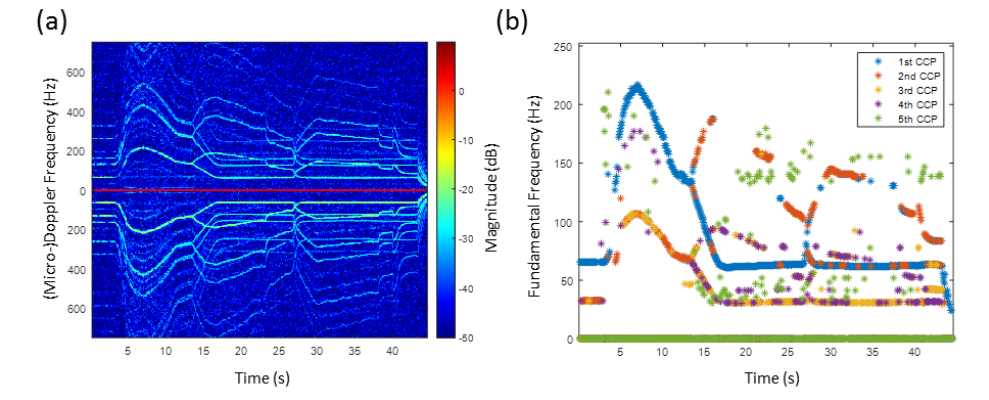
Figure 7. ( a ) HERM lines spectrogram for quadcopter measured by C-band radar; ( b ) corresponding multi-frequency detector